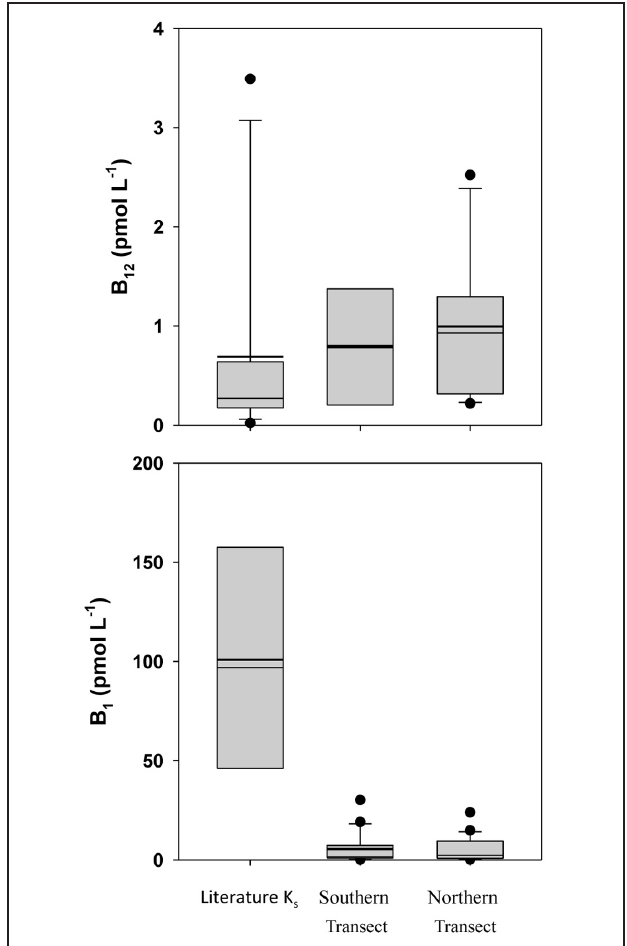
FIGURE 4 | Box-and-whisker plot Comparison of observed B-vitamin concentrations with literature Ks half-saturation constants for growth. Dots represent outlier values (Taylor and Sullivan, 2008; Tang et al.,